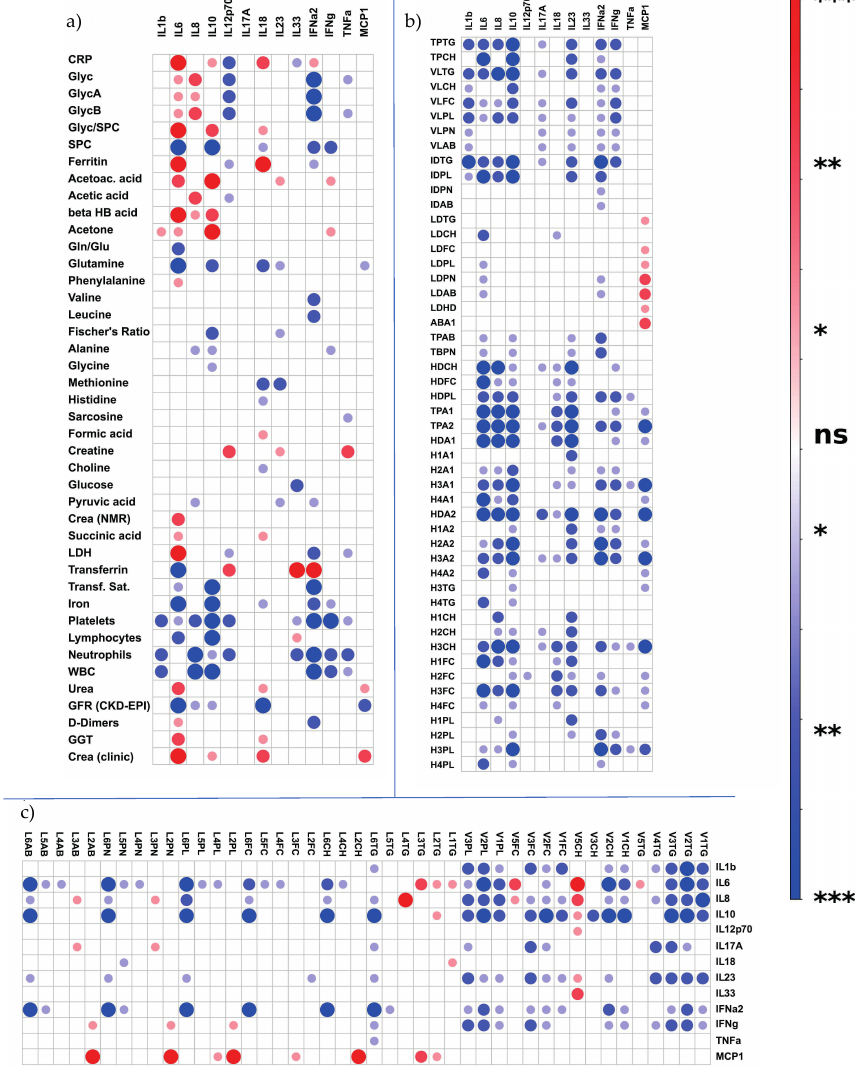
Figure 7. Analysis of correlations between different NMR and clinical parameters and cytokines. The different significance levels are color-coded (see legend on the right). Red dots indicate a positive correlation, and blue dots indicate a negative correlation. One asterisk implies a p -value of <0.05, two asterisks are equivalent to a p -value of <0.01 and three asterisks indicate a p -value of <0.001. On the left side, under ( a ), the figure shows the correlations of the measured cytokines with acute phase proteins, Glyc and SPC, ketone bodies, amino acids and other parameters from B.I. QUANT-PS™, as well as parameters from the clinical laboratory. On the right, under ( b ), the figure shows the correlations of the cytokines with the main parameters from the lipid fraction, as well as with all the markers from the HDL subfraction. The correlations of cytokines with the remaining markers from the other lipid subfractions are displayed under ( c ). A list of used abbreviations can be found in the Supplementary Materials (Table